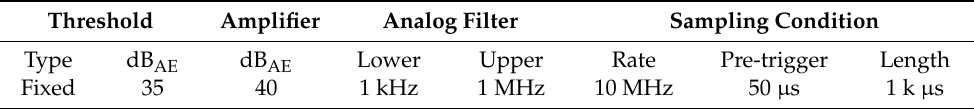
Table 1. Acoustic emission testing conditions [30]. (Length: recording time after the AE signal exceeded the threshold value.).